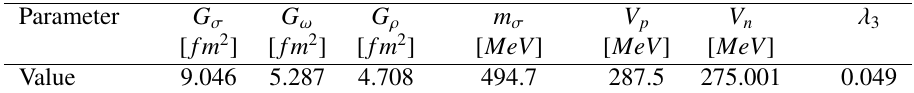
Table 1. The values of QMC π -II model free parameters: coupling constants for di ff erent mesons ( G m for m = σ , ω , ρ ), σ -meson mass ( m σ ), pairing parameters ( V p , V n ) and σ -meson self-interaction parameter ( λ 3 ), fitted to experimental data from Wang and Audi [4].